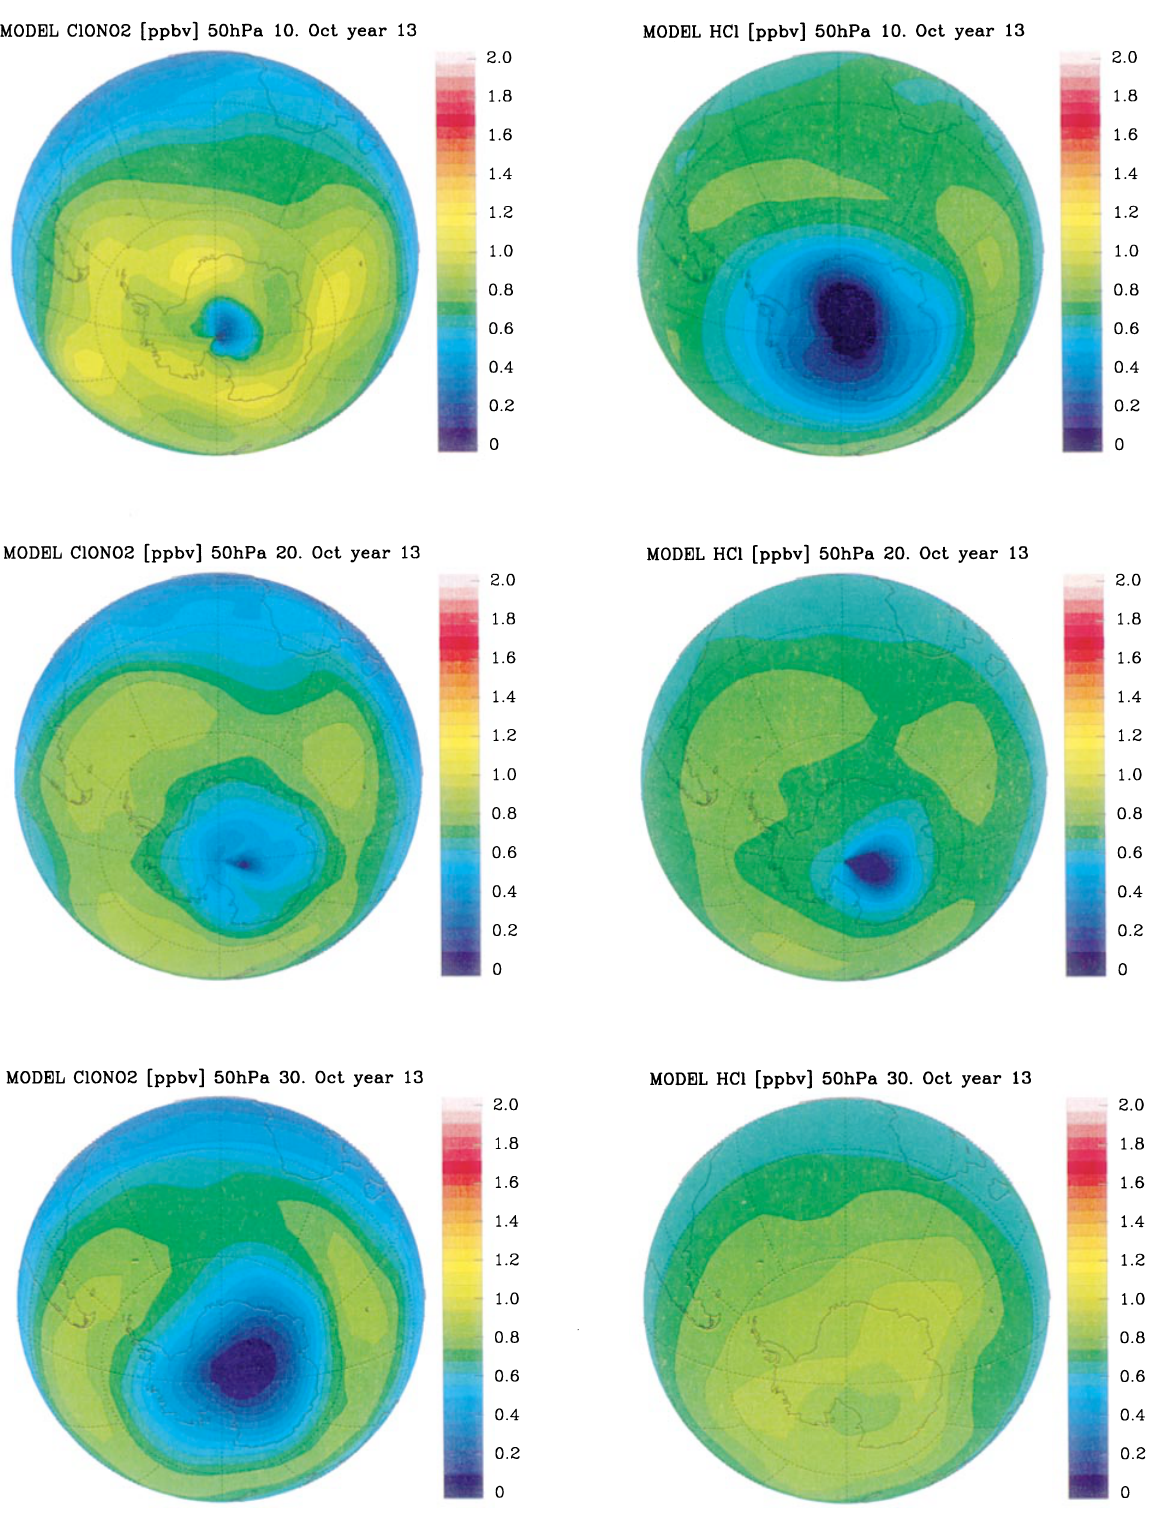
Fig. 14. Southern-hemisphere charts of ClONO Units are